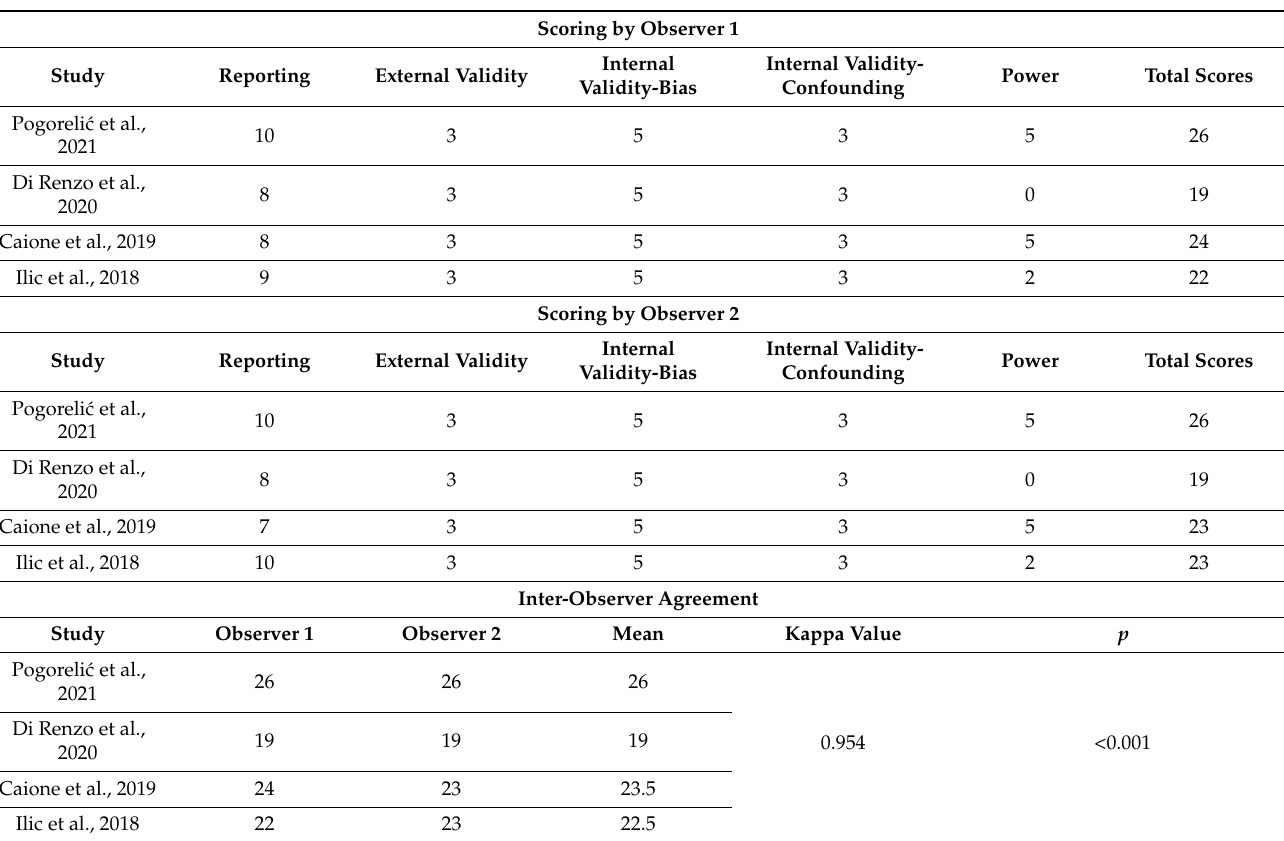
Table 2. Downs and Black scale scores assigned to each included study by both